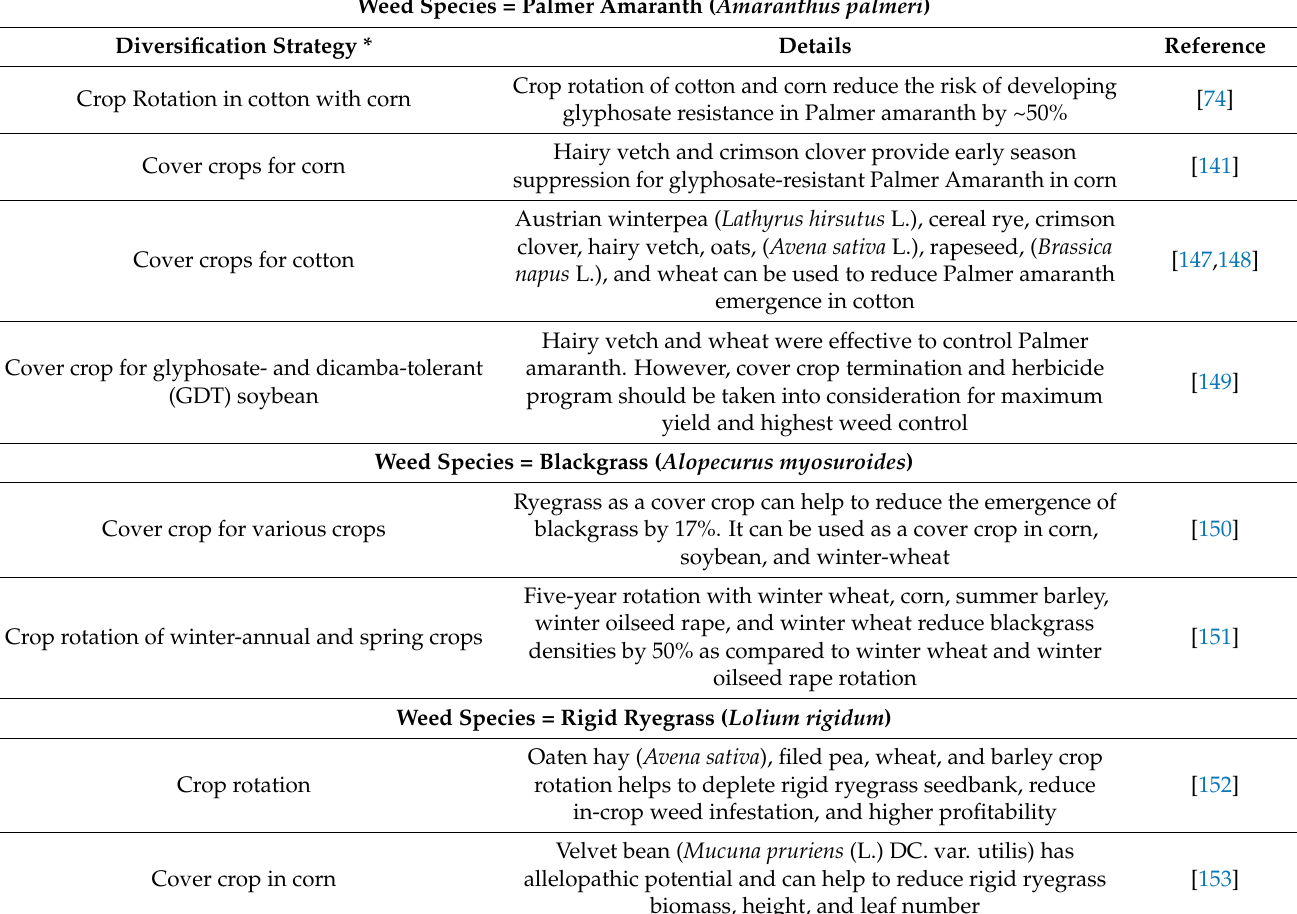
Table 1. Crop diversification recommendations to control Palmer Amaranth, Blackgrass, and Rigid Ryegrass. Weed Species = Palmer Amaranth ( Amaranthus palmeri